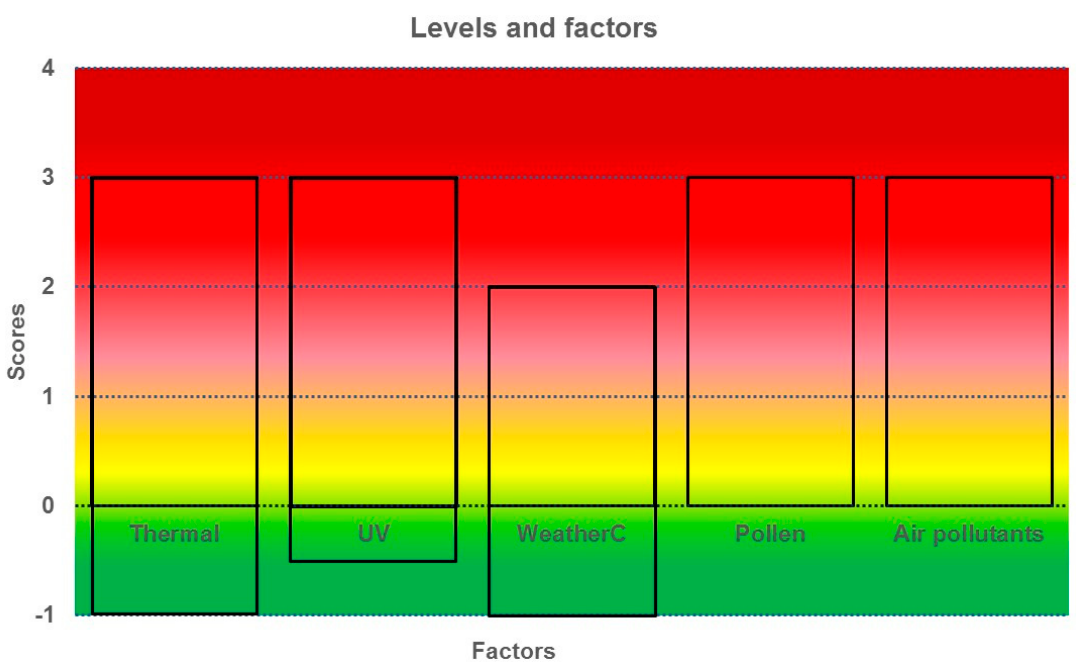
Figure 4. Scores and levels of different components and factors. In some cases, the score can be negative indicating positive effects. The scores are only an exemplary indication of the different levels.